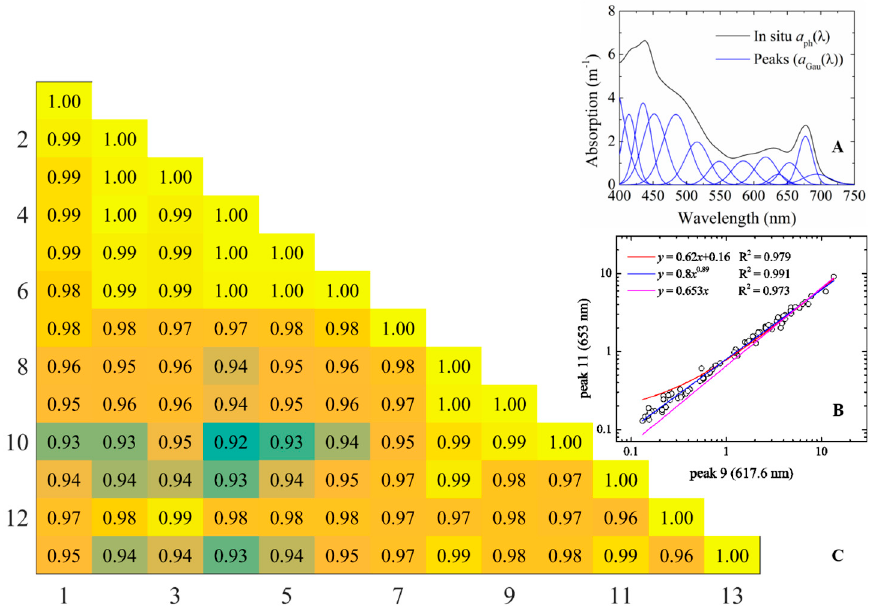
Figure 3. ( A ) Example of in situ a ph ( λ ) and corresponding decomposed a Gau ( λ ). ( B ) The scatter plot shows different functions between peak magnitudes ( a Gau ( λ )) and the corresponding R 2 . ( C ) Correlation matrix shows the co-variances among peaks (R 2 ).